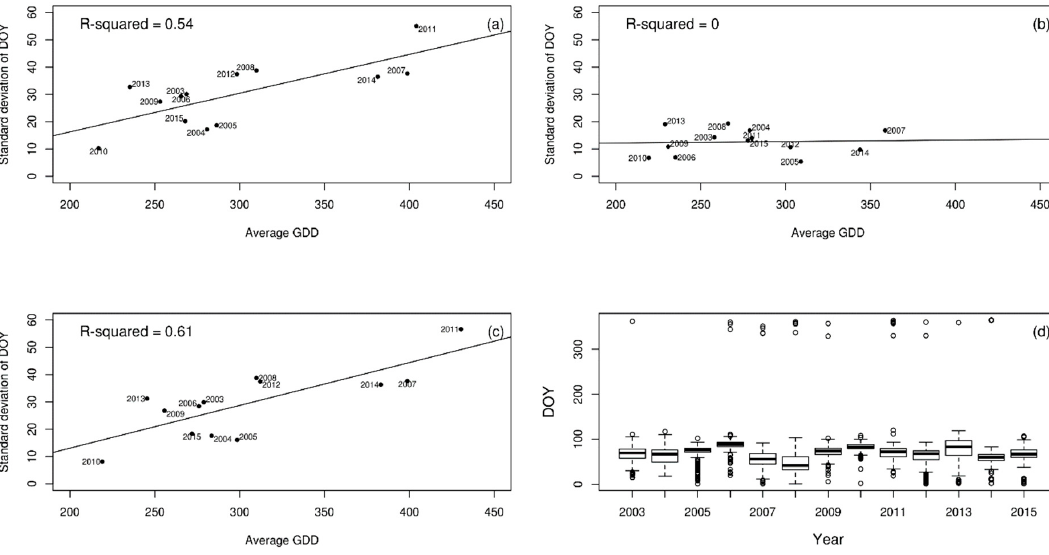
Figure 7. Lesser celandine flowering onset synchrony models for ( a ) original, ( b ) outlier-free and ( c ) consistent observations. Panel ( d ) shows annual boxplots of the reported DOYs for the original observations.